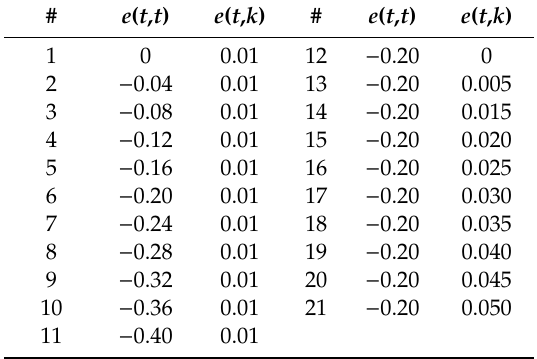
Figure 15. Load profile of DR for each configuration : ( a ) Configurations 1–11 and ( b ) Configurations